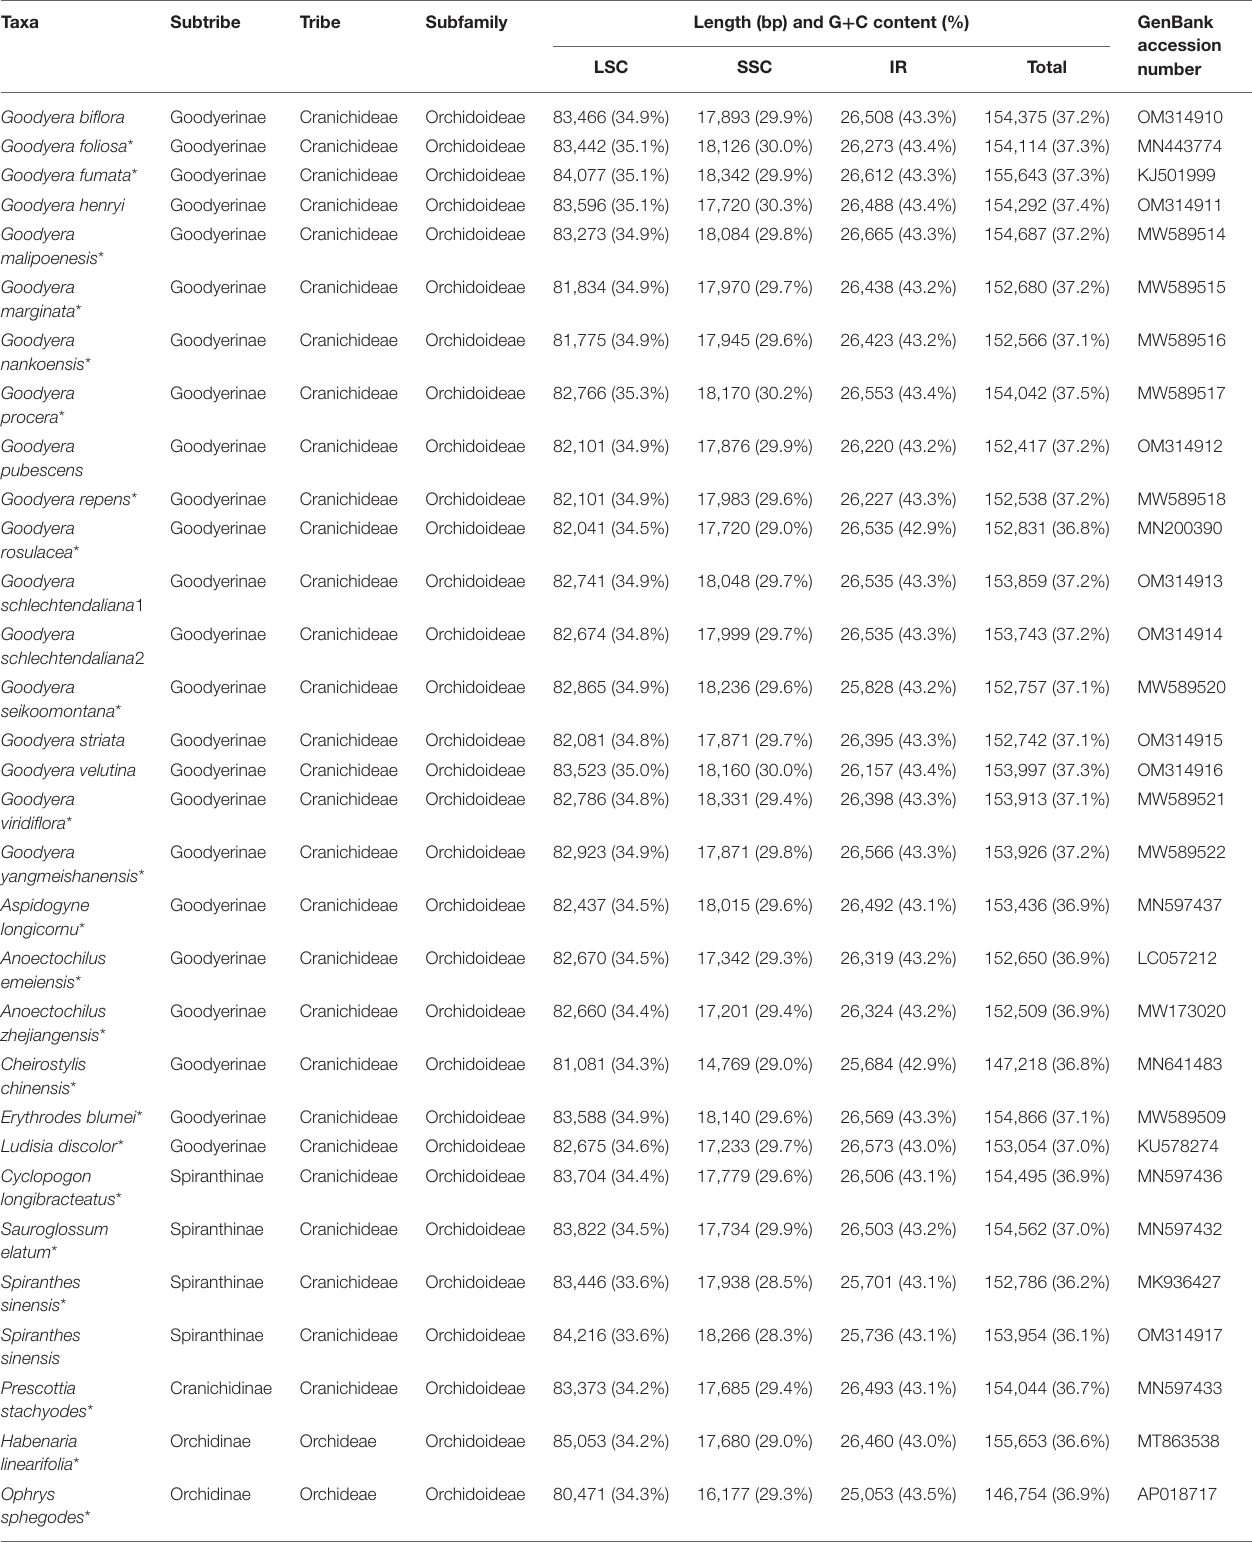
TABLE 1 | Comparison of the plastome features of Goodyera and related